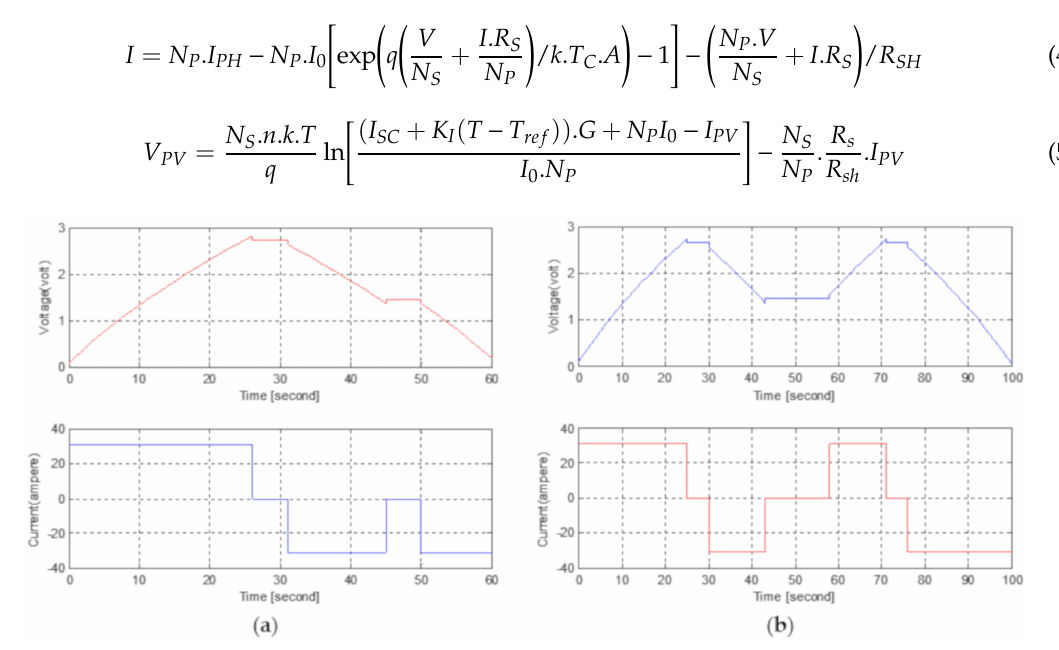
Figure 5. ( a ) CAP / ESR measurement waveforms, ( b ) cycle life waveforms simulation results.